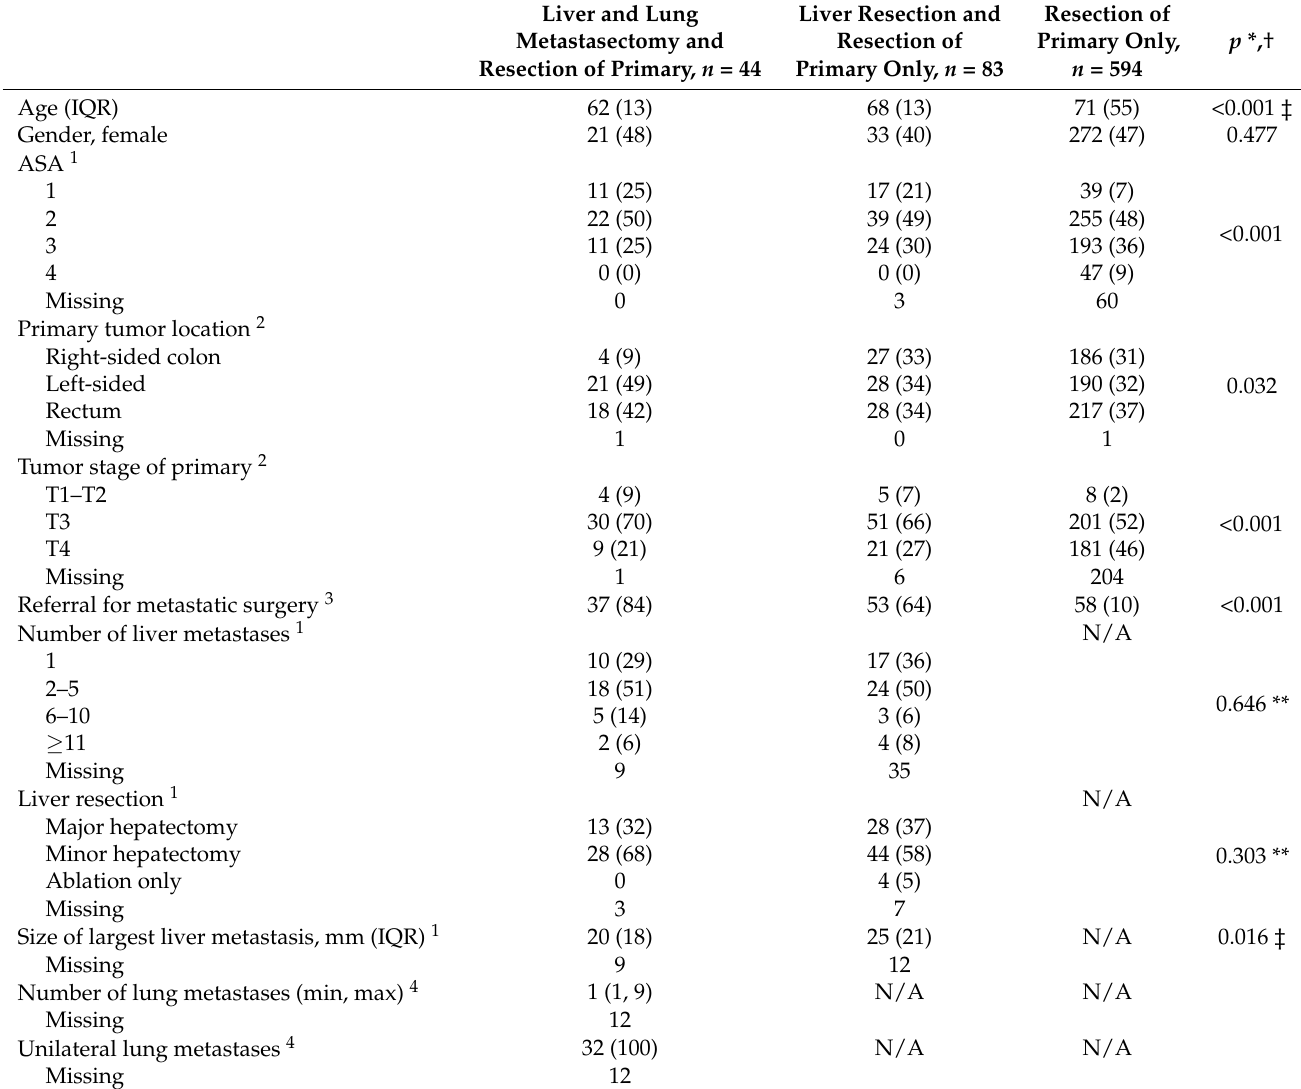
Resection of Liver Resection and Primary Only, Resection of n = Primary Only, n = 83